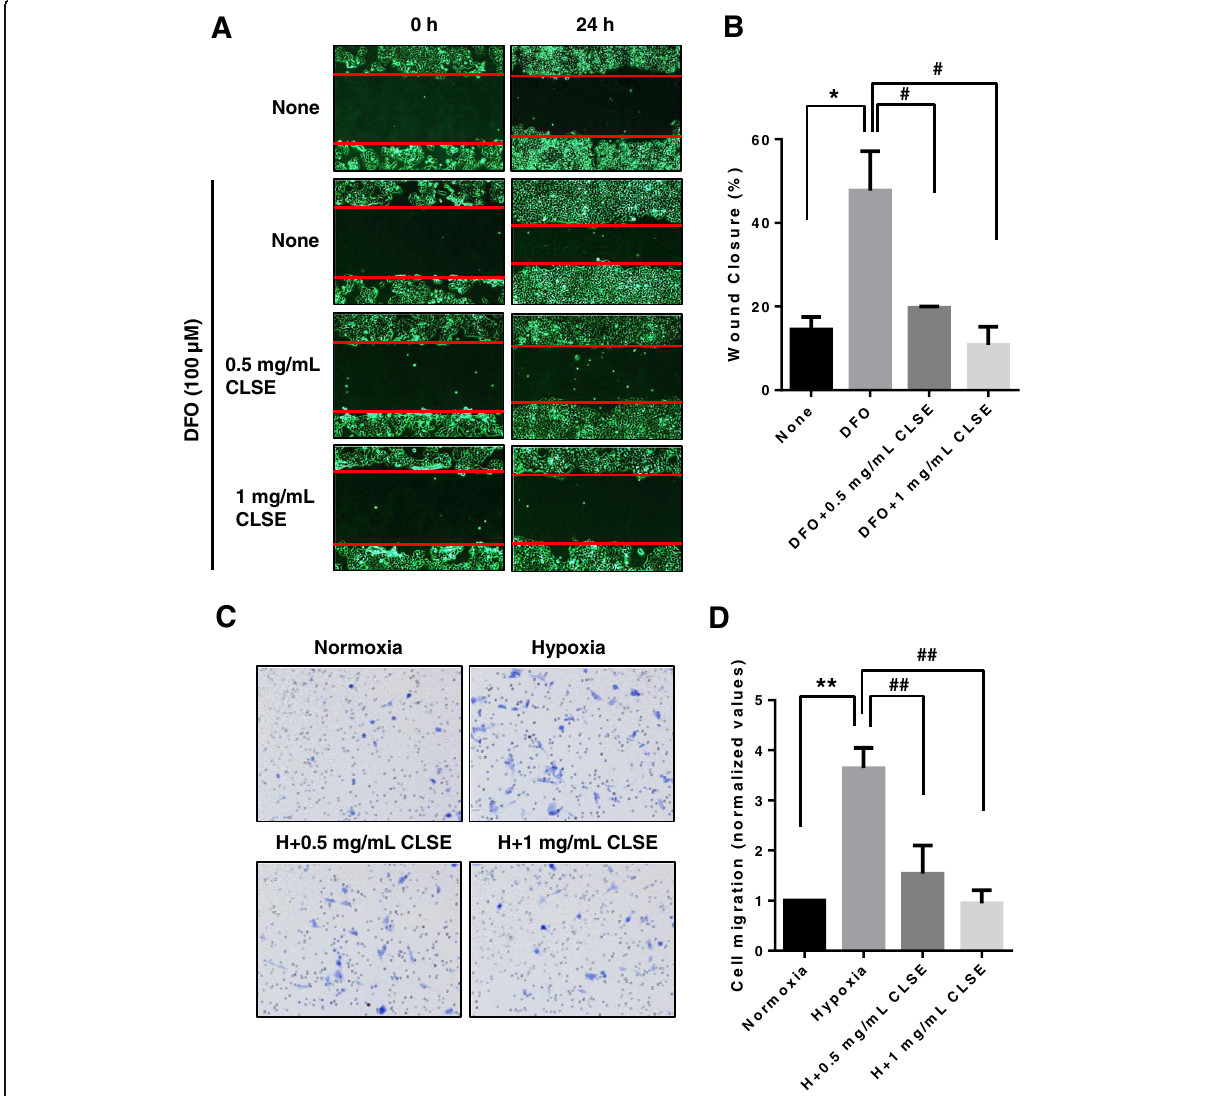
Fig. 2 Effect of CLSE on the migratory ability of HCT116 cells under hypoxic conditions. a . Representative scratch-wound images showing the effect of CLSE on the healing ability of HCT116 cells (magnification: ×40). After with treatment DFO (100 μ M) and CLSE (0.5, 1 mg/mL) for 24 h, the migratory ability was analyzed by scratch-wound healing assay. b . Percentage of HCT116 cells that migrated into the wound following CLSE treatment relative to untreated control cells. * p < 0.05 versus untreated control group. # p < 0.05 versus DFO-only group. c . Representative images showing the effect of CLSE on HCT116 cell migration through a Transwell® chamber membrane (magnification: ×200). After treatment with CLSE (0.5, 1 mg/mL) for 24 h, the migration cells in transwells were stained by crystal violet solution. d . Percentage of HCT116 cells that migrated following CLSE treatment relative to control cells (normoxia). ** p < 0.01 versus normoxia control group. ## p < 0.01 versus hypoxia-only group. Data are mean ± SD ( n = 3). CLSE, Coix lacryma-jobi var. ma-yuen Strapt sprout extract; H, hypoxia; SD, Standard